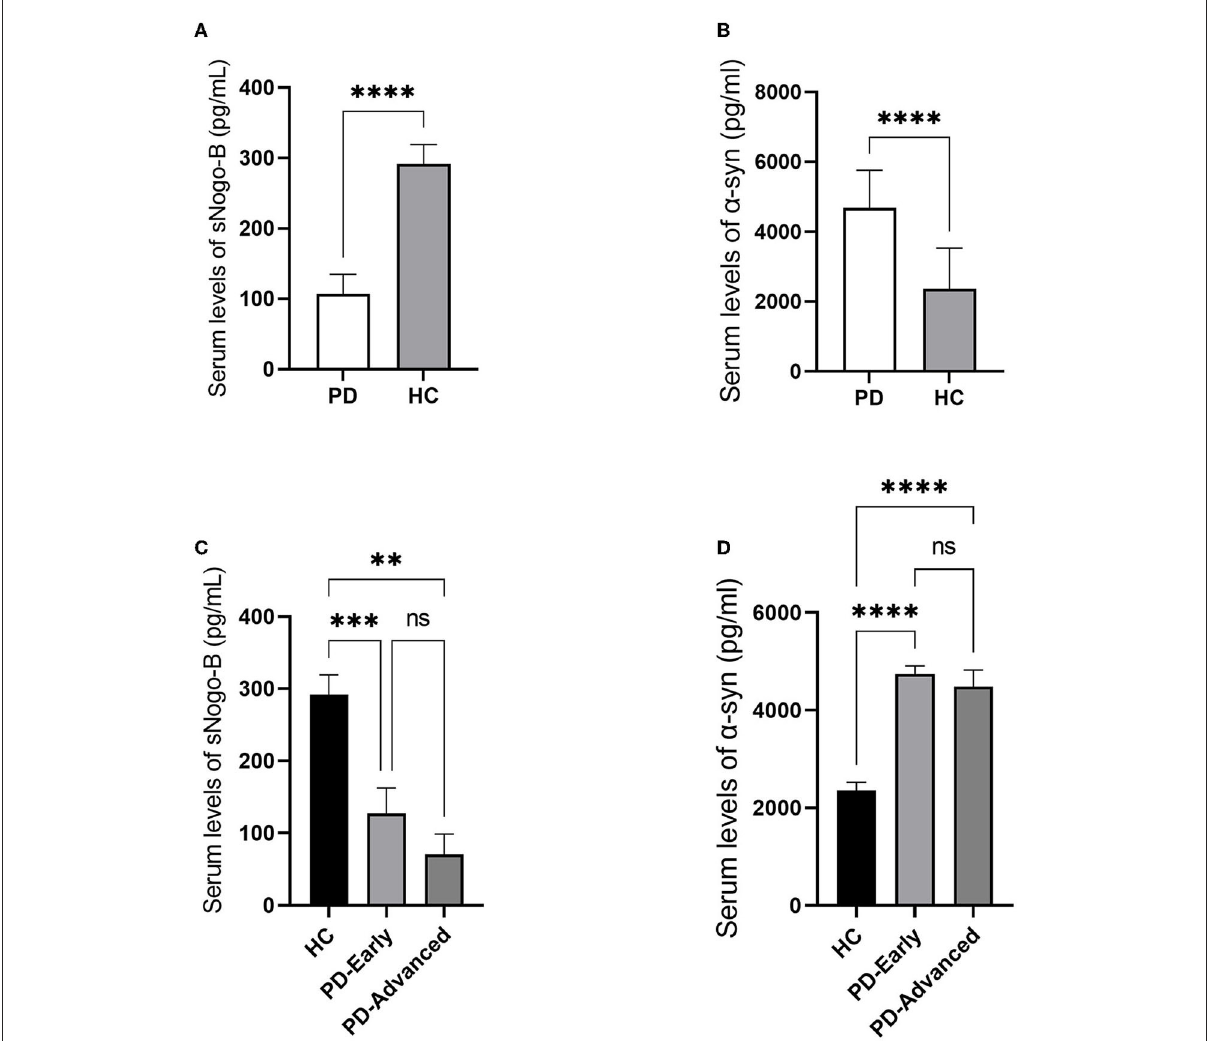
FIGURE1 Comparisons of Serum levels of sNogo-B and α -Syn in patients with PD and HC. (A) Serum levels of sNogo-B in patients with PD and HC. Patients with PD presented lower serum levels of sNogo-B than healthy control individuals ( p < 0.0001); (B) Serum levels of α -Syn in patients with PD and HC. Patients with PD presented higher serum levels of α -Syn than healthy control individuals ( p < 0.0001); (C) Serum levels of sNogo-B in early and advanced patients with PD and HC. No significant difference was observed between serum sNogo-B levels of early and advanced patients with PD ( p = 0.521); (D) Serum levels of α -Syn in early and advanced patients with PD and HC. No significant difference was observed between serum α -Syn levels of early and advanced patients with PD ( p = 0.857); PD, Parkinson’s disease; α -Syn, α -Synuclein; HC, healthy controls. ** , p < 0.01; *** , p < 0.001; **** , p < 0.0001; ns, not